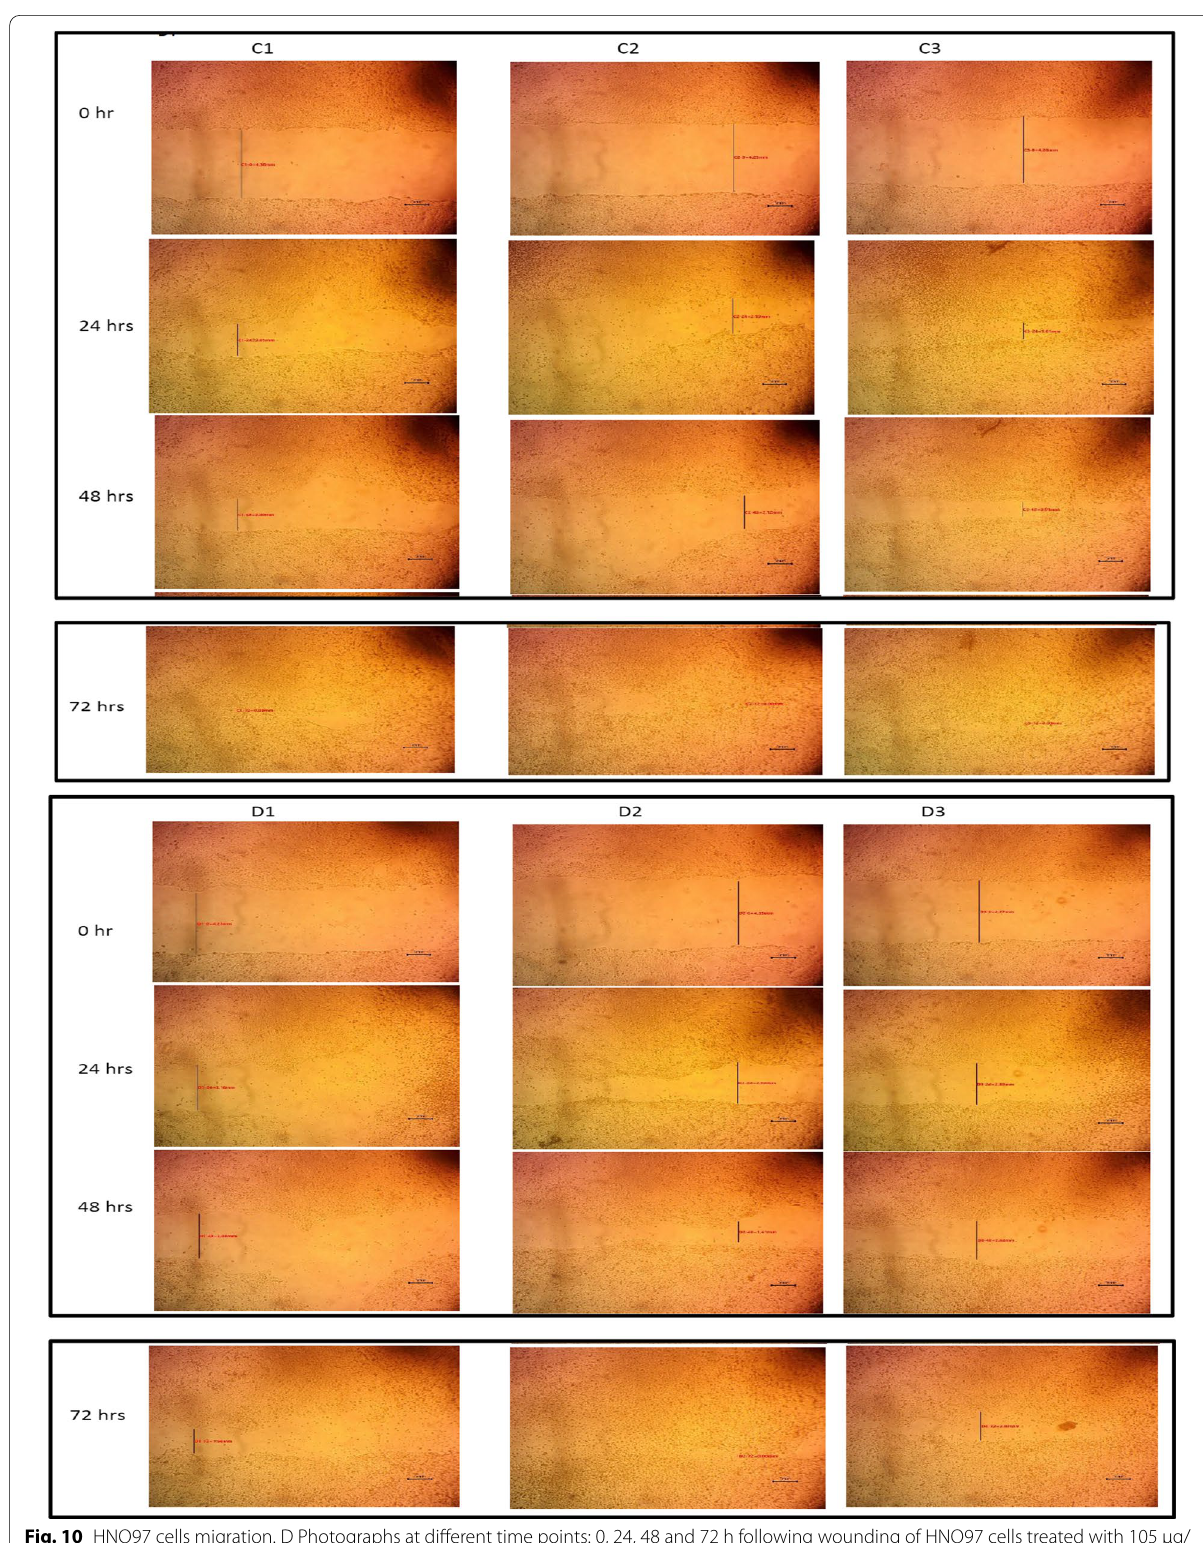
Fig. 10 HNO97 cells migration. D Photographs at different time points: 0, 24, 48 and 72 h following wounding of HNO97 cells treated with 105 µg/ mL apricot oil extract. C Photographs at different time points: 0, 24, 48 and 72 h following wounding of untreated HNO97 cells. In each group of cells, six fields were evaluated. Data are presented as mean ±